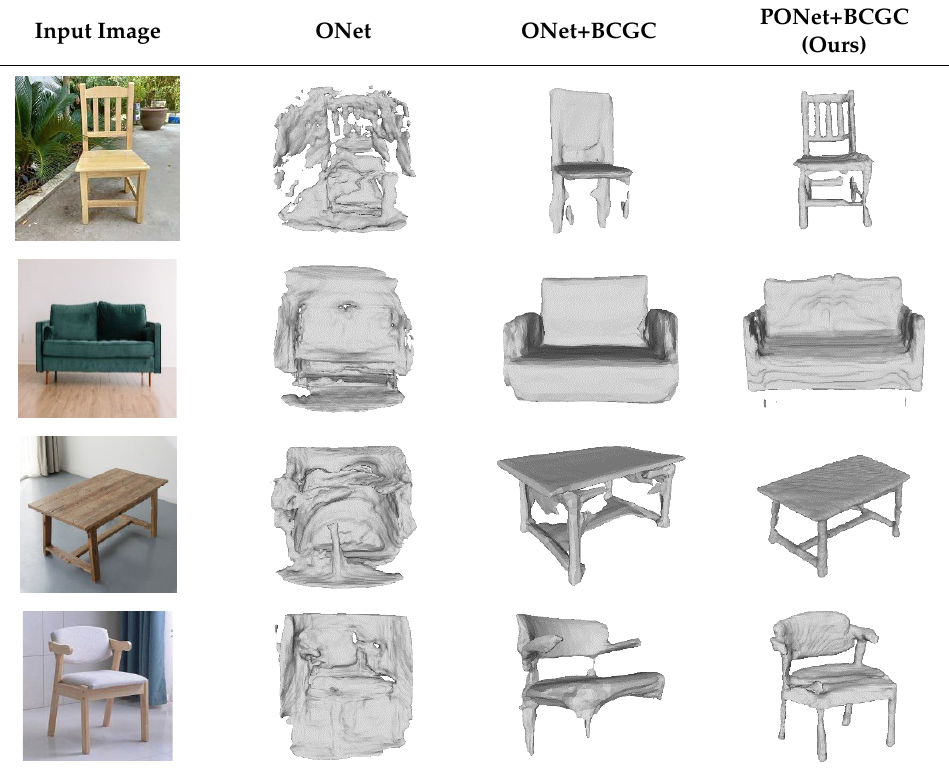
Table 5. Comparison of 3D reconstruction effect including complex furniture background.